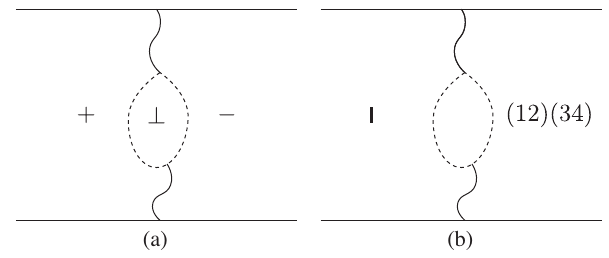
FIG. 5. (a) A domain wall configuration with a ⊥ cluster. The weight is nonzero only when the domain wall passes through the ⊥ cluster. (b) The average of the square of (a) in terms of the S spin model. The spin states outside the cluster are